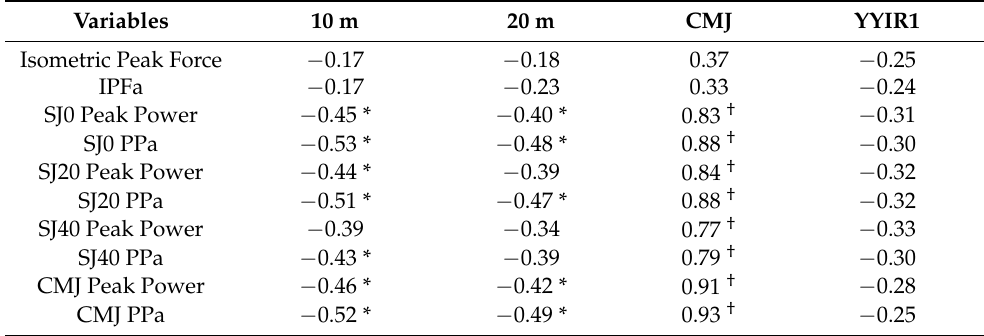
Table 2. Correlations between Maximum Strength and Power Characteristics and Sprinting, Jumping, and Intermittent Endurance